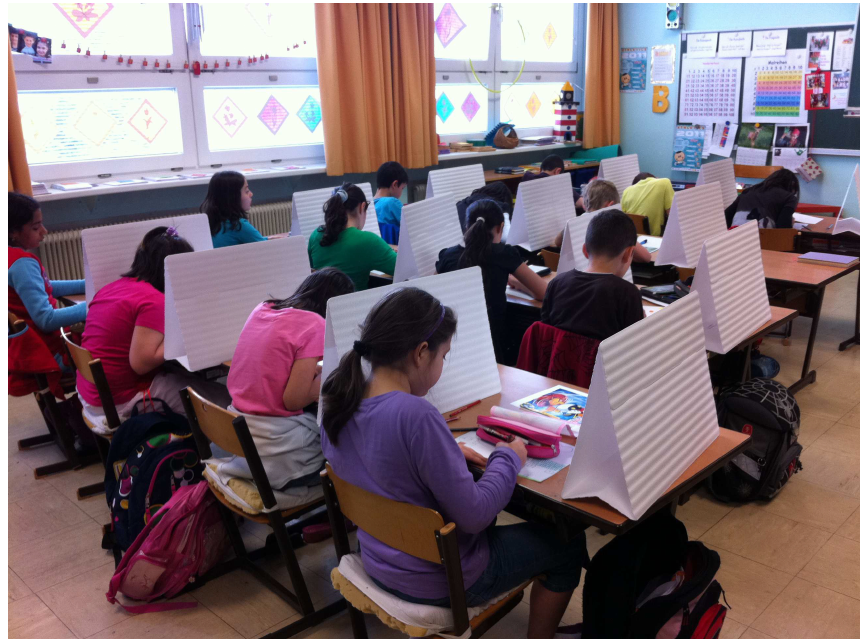
Figure 1. The classroom experimental